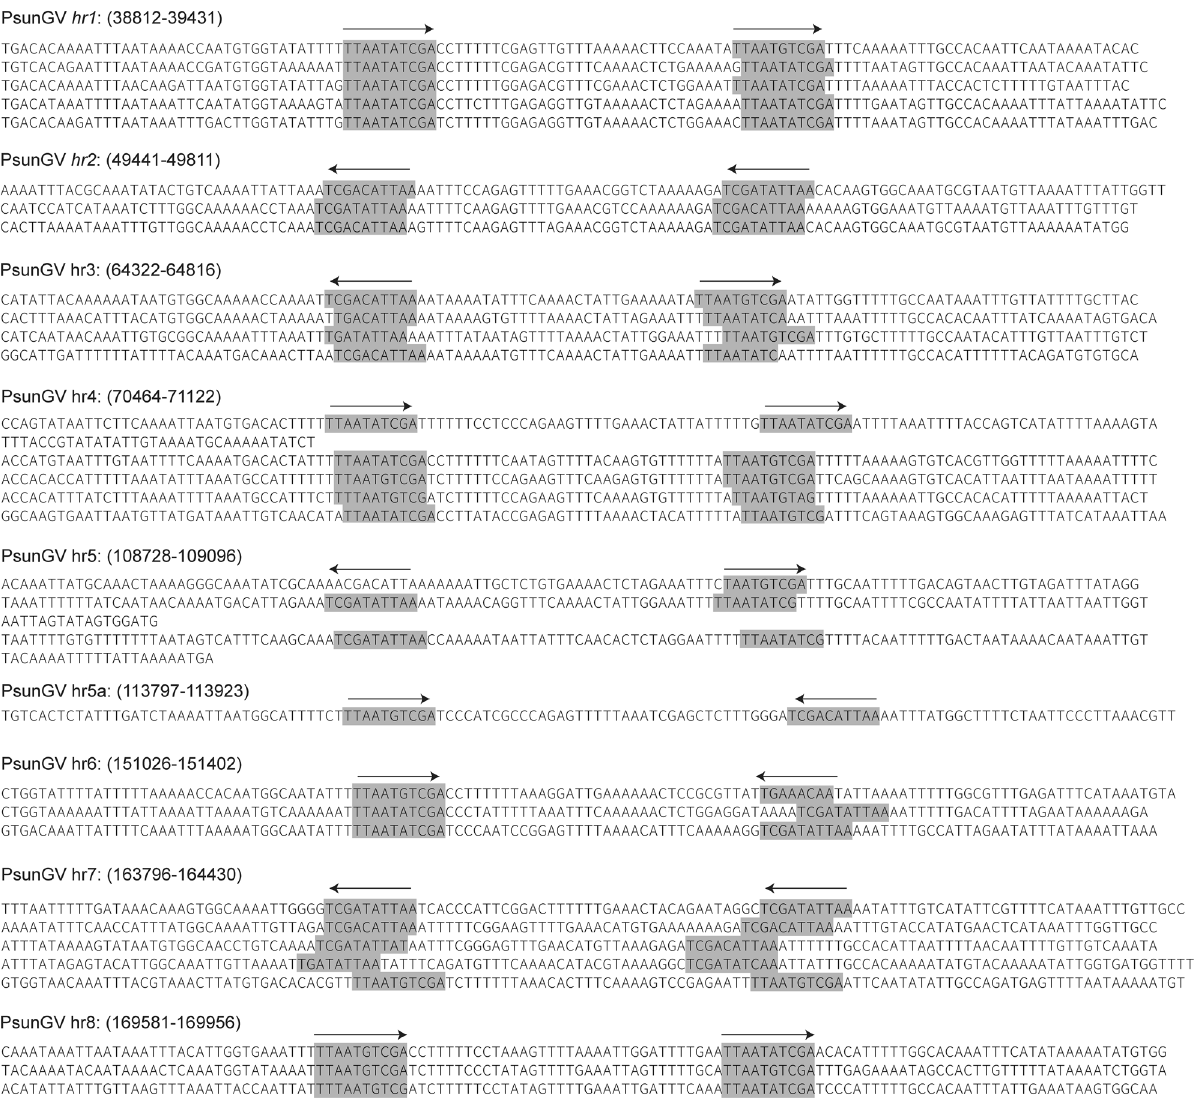
Figure 3. Alignment of homologous regions in the MyunGV-A genome. The conserved 10 bp core sequences (TTA ATG /ATCGA) are indicated by shaded boxed. The arrows indicate direction of core Two genes, ORF53 and ORF157, in the HearGV genome are homologous, with amino acid sequence identities of 86% and 85%, respectively, and the amino acid sequence identity of ORF53 and ORF157 in the HearGV genome is 99%. One gene with two copies in one baculovirus genome was found in other baculovirus genomes, such as odv-e66, p26 and dbp of EcobNPV 36 and odv-e66 and p26 of SfMNPV 37 . BLAST results of amino acid sequences of these two homologous genes in MyunGV-A in NCBI suggested they match hr3 and hr4 of Heliothis virescens ascovirus 3e (amino acid sequence identities both 49%). In addi- tion, they match the 70.4-kDa C-terminal Zn-finger DNA-binding domain of Spodoptera frugiperda ascovirus 1a (amino acid sequence identities of 48%), which suggests that their function may be associated with DNA binding. ORFs with no homologues in other baculoviruses. Three ORFs, including ORF113, -133 and -166, were identified as having no homologues in other baculoviruses (Table 1). These three unique ORFs have no rec- ognizable promoter. Protein homology analysis using HHpred showed that GP133 (aa 50–359) is a likely homo- logue of Mannan-binding lectin serine peptidase 1 (probability, 99.97%; E value, 1.1e-28). Mannan-binding lectin serine peptidase 1 plays a central role in the initiation of the complement lectin pathway 38 . This homology indicates that ORF133 might be related to the complement lectin pathway, which deserves further research. ORF113 encodes an 8.5-kDa protein with one transmembrane domain (aa 5–27, analysed by TMHMM server v2.0) at the N terminus of the protein with no similarity to any proteins in the nonredundant protein database. ORF166 encodes a 7.7-kDa protein with no similarity to any proteins in the nonredundant protein database.